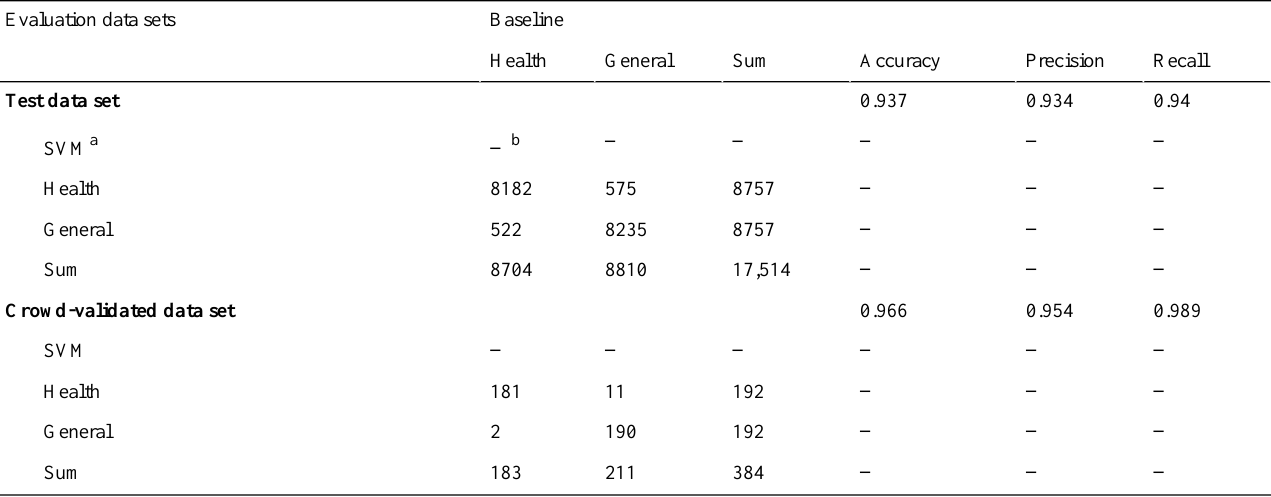
Table 3. Listing of the confusion matrix and related evaluation metrics for the test and crowd-validated data